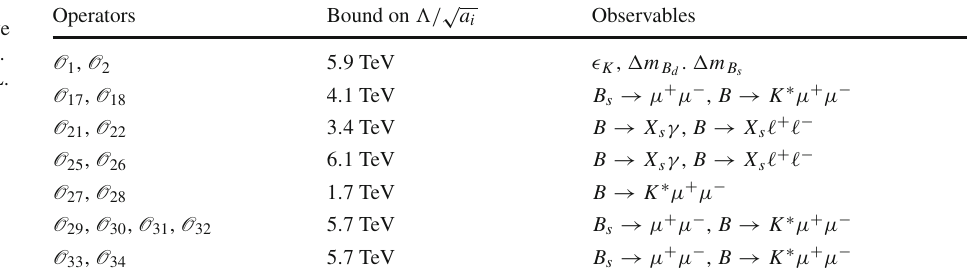
Operators Bound on (cid:4)/